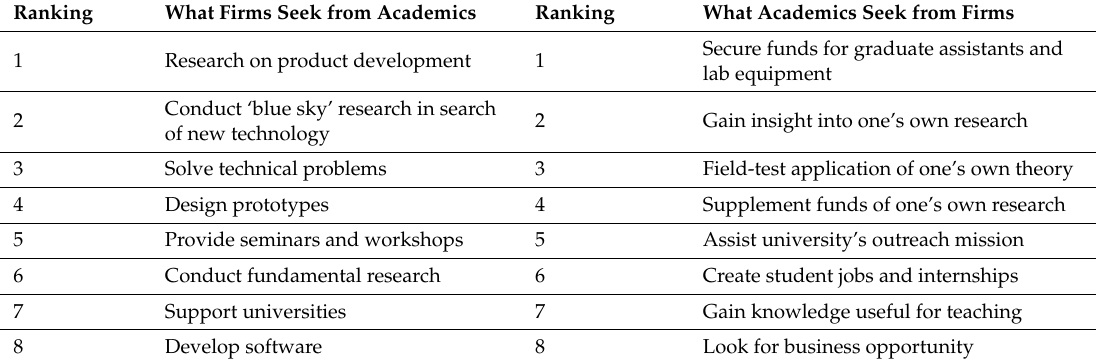
Table 6. Hierarchy of the underlying motivations of university faculty and firms manifested in research